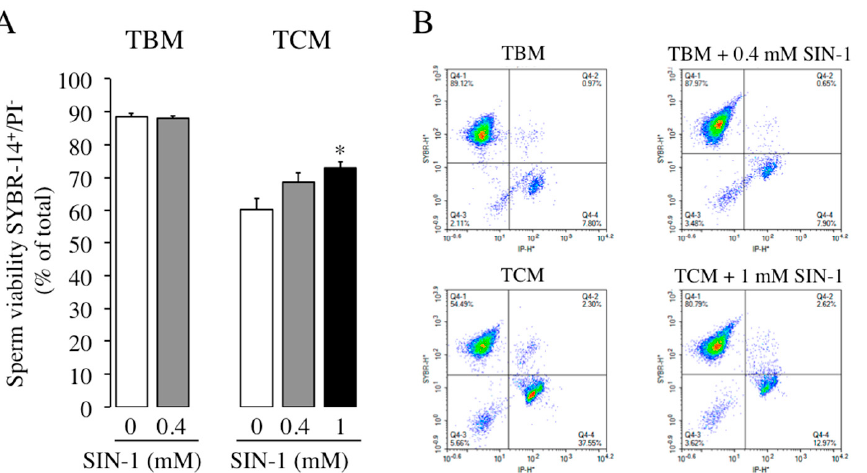
Figure 5. Effect of SIN ‐ 1 induced ‐ peroxynitrite in boar spermatozoa viability. ( A ) Boar spermatozoa were incubated in TBM or TCM at 38.5 °C in the absence (white histograms) or presence of SIN ‐ 1 (filled histograms) for 1 h. ( B ) Representative two ‐ dimensional SYBR ‐ 14 fluorescence versus PI fluorescence dot plots for sperm samples incubated in presence or absence of SIN ‐ 1 are shown. This experiment was performed 8 times ( n = 8) and the results are expressed as the percentage of SYBR14 ‐ positive and PI ‐ negative spermatozoa ± SEM. Statistical differences are shown with * ( p < 0.05).